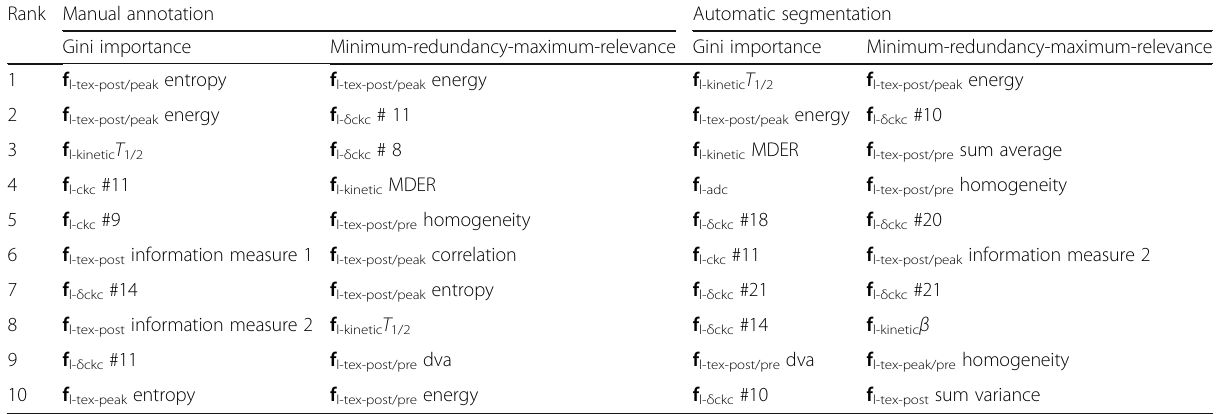
Table 6 The ten top-ranked classification features according to Gini importance and